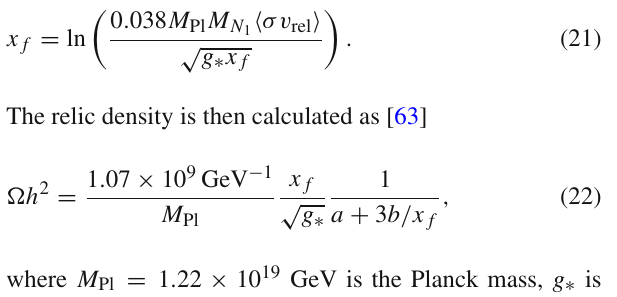
Fig. 4 Predictions for | (cid:17) a μ | . In this figures, we have fix M N GeV in Fig. 4. We find that the bound from | (cid:17) a μ | < 10 − 10 is